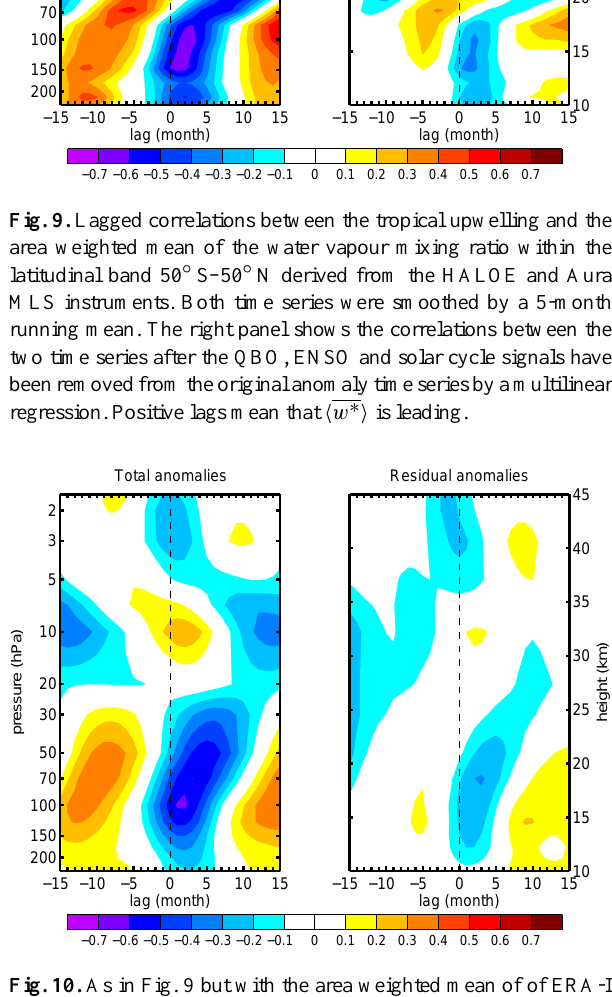
Fig. 10. As in Fig. 9 but with the area weighted mean of of ERA-I Fig. 10. As in Fig 9 but with the area weighted mean of of ERA-I specific humidity in the latitudinal band specific humidity in the latitudinal band 50 ◦ S–50 ◦ N. 50 ◦ S–50 ◦ N. those models, westerly shear zones of the QBO are associ- ated with sinking anomalies of the residual circulation at the equator, whereas the easterly shear zones are associated with rising